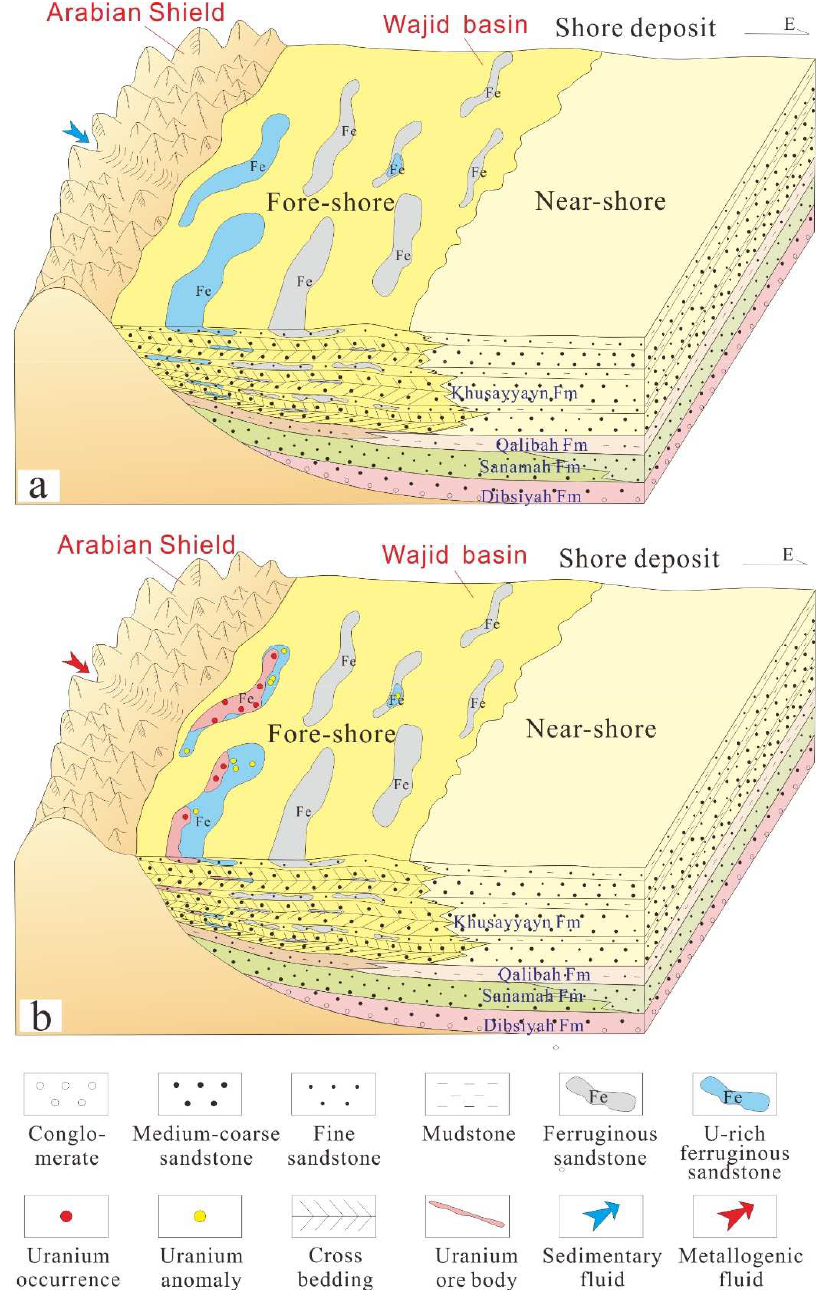
Figure 11. Uranium metallogenic model of Wajid ferruginous sandstone. ( a ). Sedimentary and diagenetic period of ferruginous sandstone; ( b ). Ferruginous sandstone transformation period.